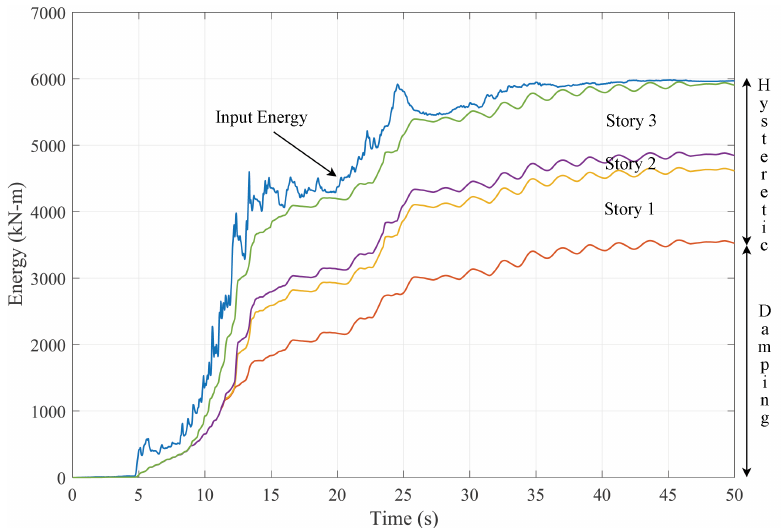
Figure 1. Development of damping, hysteretic and input energy in a MDOF system with time.